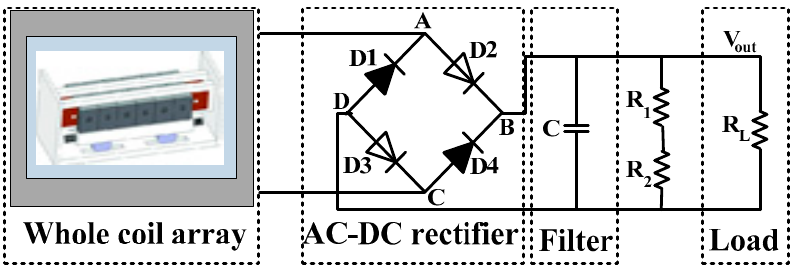
Figure 16. Standard energy-harvesting circuit [28].